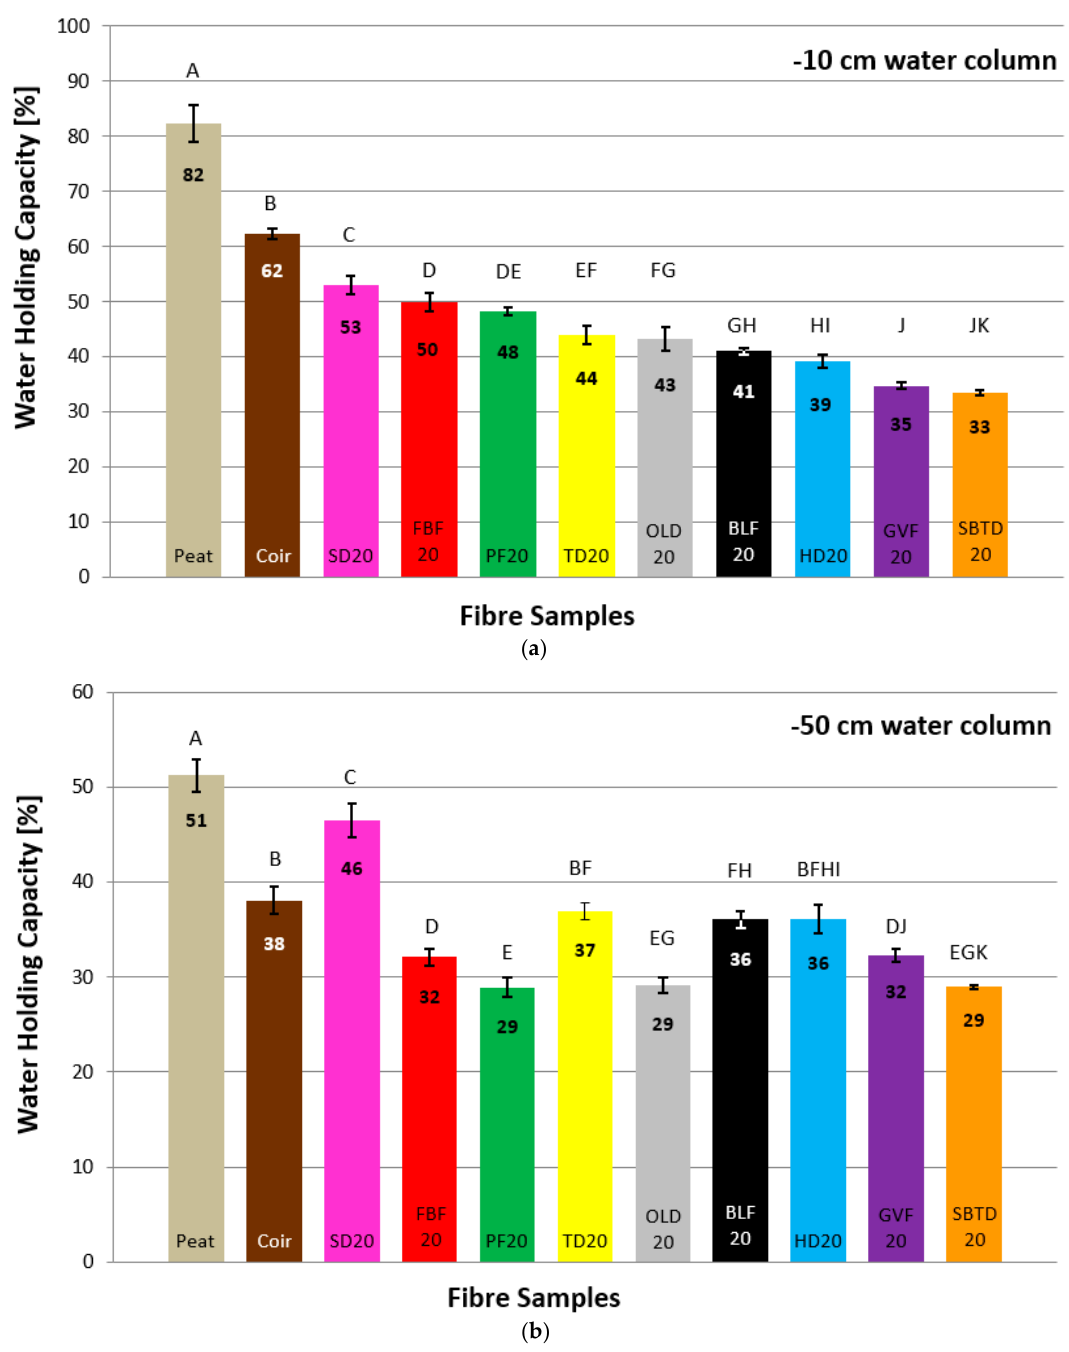
Figure 7. ( a ) WHC at − 10 cm ( − 1 kPa suction tension) and ( b ) − 50 cm ( − 5 kPa suction tension) water column and standard deviation as a function of raw material, which was extruded at a 20 mm aperture. Different letters indicate significant differences between raw materials for α = 0.05.